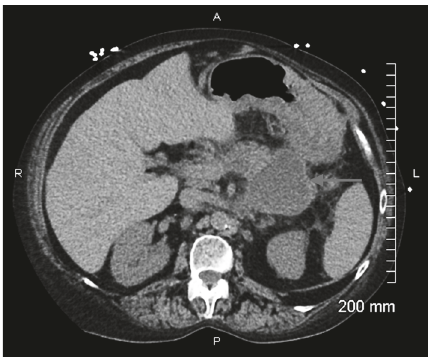
Figure 1: CT image; pancreatic tail lesion.